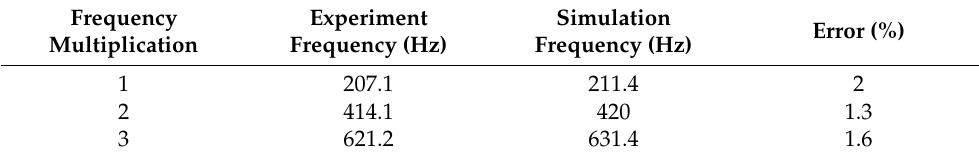
Table 10. Frequency comparison Table 9. Comparative analysis of the fluid pressure fluctuation value and pressure fluctuation rate.